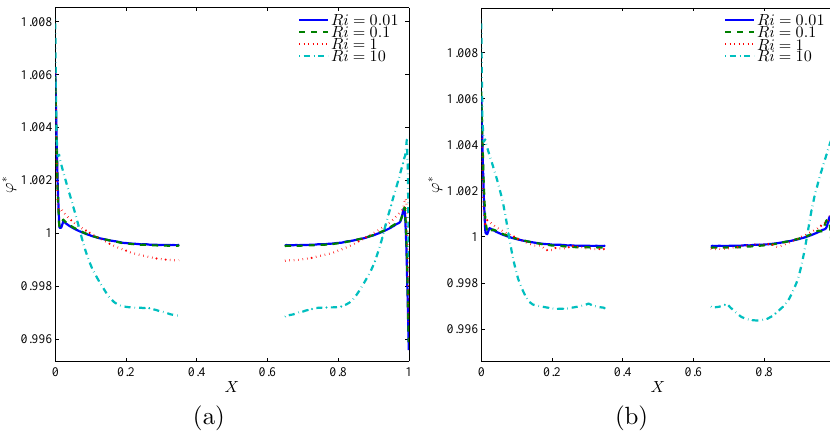
Figure 10. Variations of local normalized solid volume fraction interfaces with the horizontal center line ( Y = 0.5) for different Ri at ( a ) Case 1 ( Ω ) and ( b ) Case 2 ( − Ω ) for φ = 0.02, N = 0, and R =